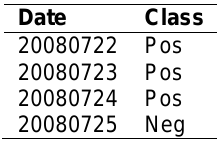
Table 5. Probability calculation for positive class